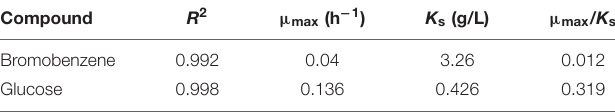
TABLE 2 | Growth kinetic parameters a for Yarrowia lipolytica NCIM 3589 on BrB. Compound R 2 µ max (h − 1 ) K s (g/L) µ max / K s Bromobenzene 0.992 0.04 3.26 0.012 Glucose 0.998 0.136 0.426 0.319 a Growth kinetic parameters were estimated after considering the growth of the Y. lipolytica cells on BrB and glucose for concentrations ranging between 0.1 and 2% (w/v) using the Monod